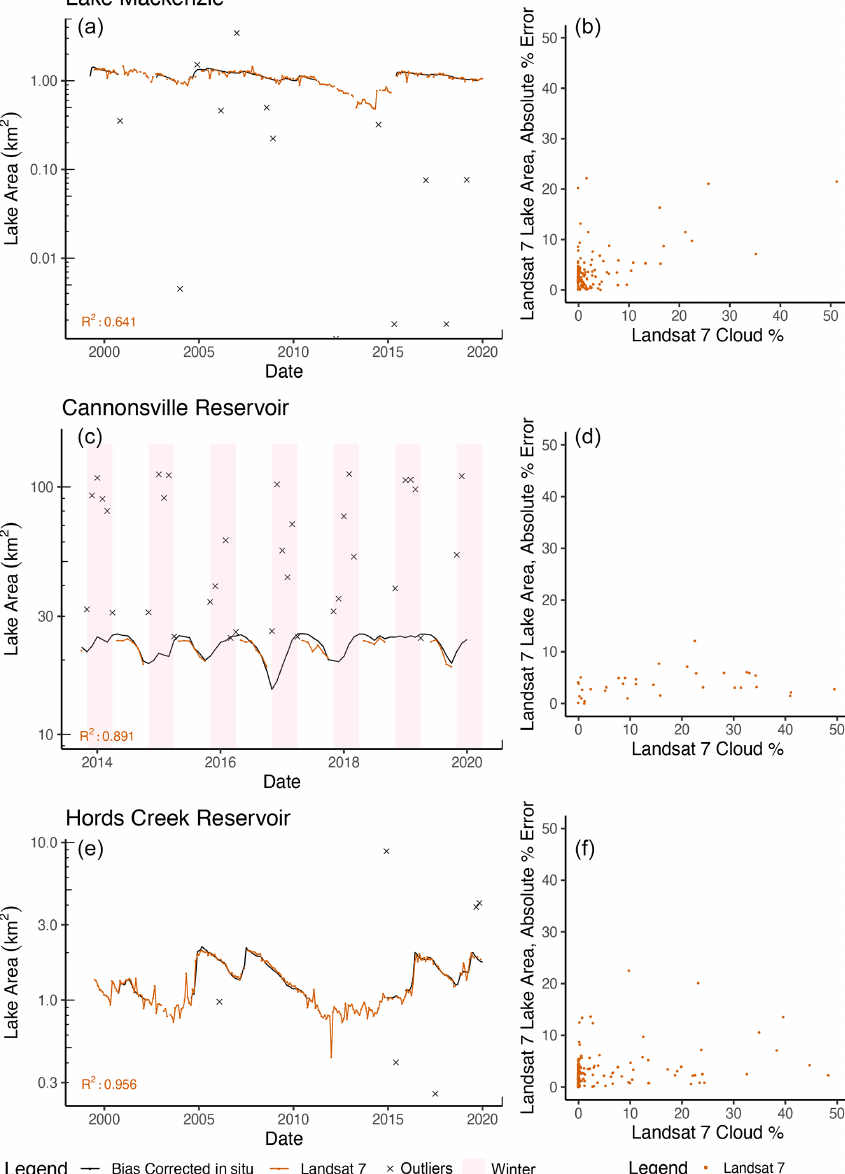
Figure 4. Application to lakes with in situ observation data. (a, c, e) Time series representation water extent from the in situ observation (black) and Landsat 7 (brown). Automatically removed outliers (crosses) are also displayed for indicative purposes. Winter months (Decem- ber to February) are shaded for Cannonsville, NY. (b, d, f) Scatterplot of absolute percentage errors on Landsat 7 water extent estimates (compared to in situ observations) against the proportion of the lake’s maximum footprint that was covered by